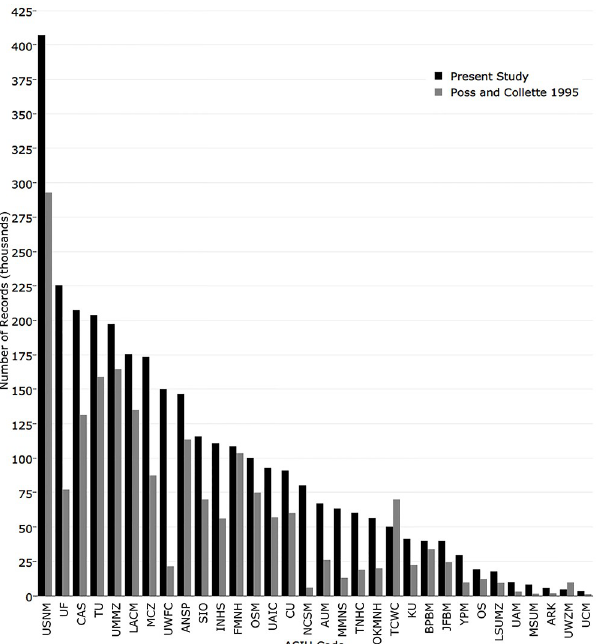
Fig 8. Comparison of the number of records published in iDigBio (black) with the number reported in Poss and Collette (1995) (grey).